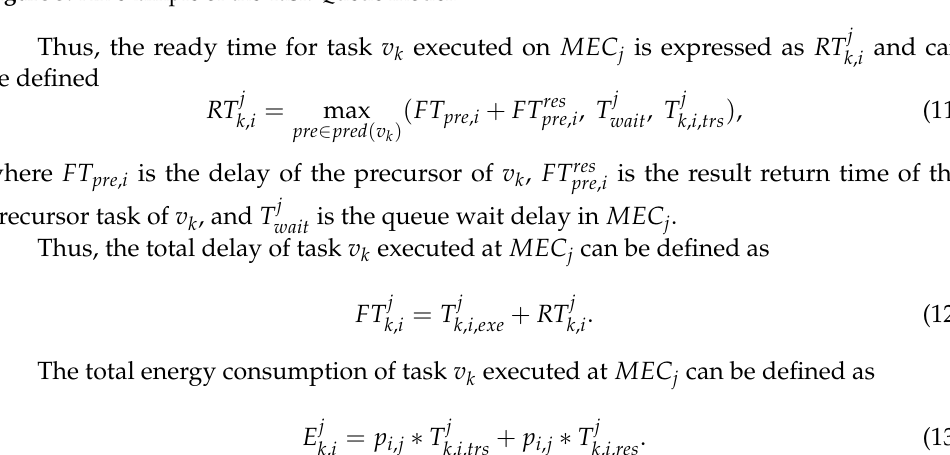
Figure 3. An example of the Task Queue model.